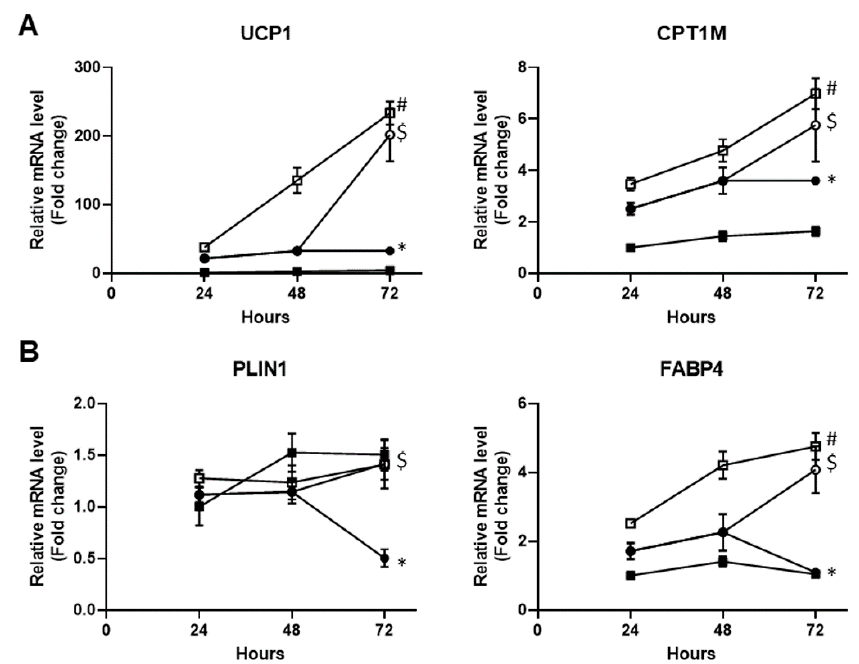
Figure 5. The CA inhibitory effect is normalized upon its removal. Conversion of white hMADS adipocytes (from day 14 to day 17) into brite adipocytes was induced with 100 nM rosiglitazone in the absence ( ) or the presence ( ● ) of 10 µM CA for 72 h. CA was removed for the last 24 h ( ). Untreated white hMADS adipocytes ( ■ ) served as the control. mRNA levels of thermogenic (UCP1 and CPT1M, ( A ) and adipogenic (FABP4 and PLIN1, ( B ) markers were analyzed. Data are displayed as mean ± SEM of two independent experiments (two replicates for each experiments). Two-way ANOVA followed by multi-comparisons and Bonferroni correction, adjusted p < 0.05 was considered significant: # , white vs. brite adipocyte; * , untreated vs. CA treated condition, $: significant for treated 72 h vs. 48 h.